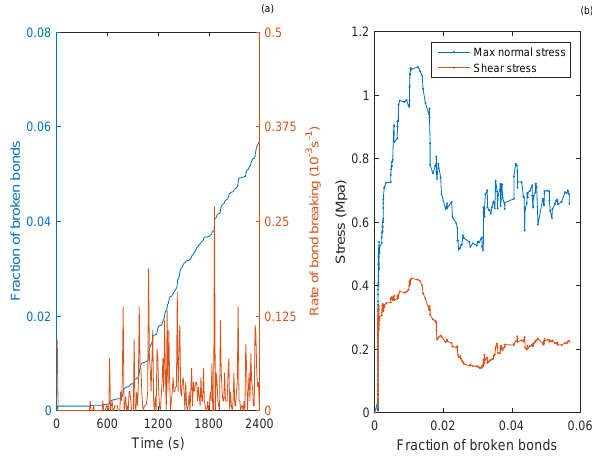
Figure 8. Temporal evolution of the fraction of broken bonds and the rate of bond breaking (a) ; relationships between the fraction of broken bonds and the global normal and shear stress in simulations under uniaxial compression (reference model settings).